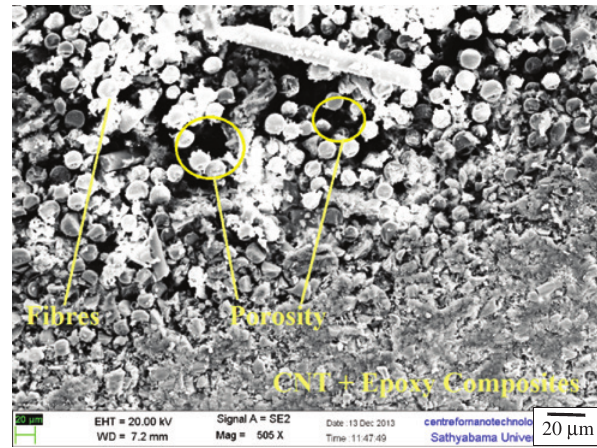
Figure 11: GFRP with CNTs 1% before wear.